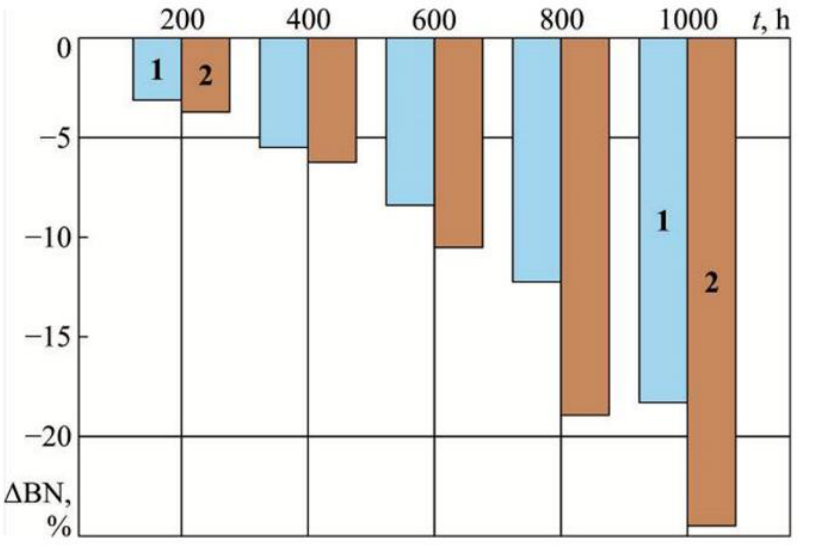
Figure 6. Relative change Δ BN oils Shell Gadinia AL 40 under different experimental conditions: 1 — diesel AE 1; 2 — diesel AE 2.